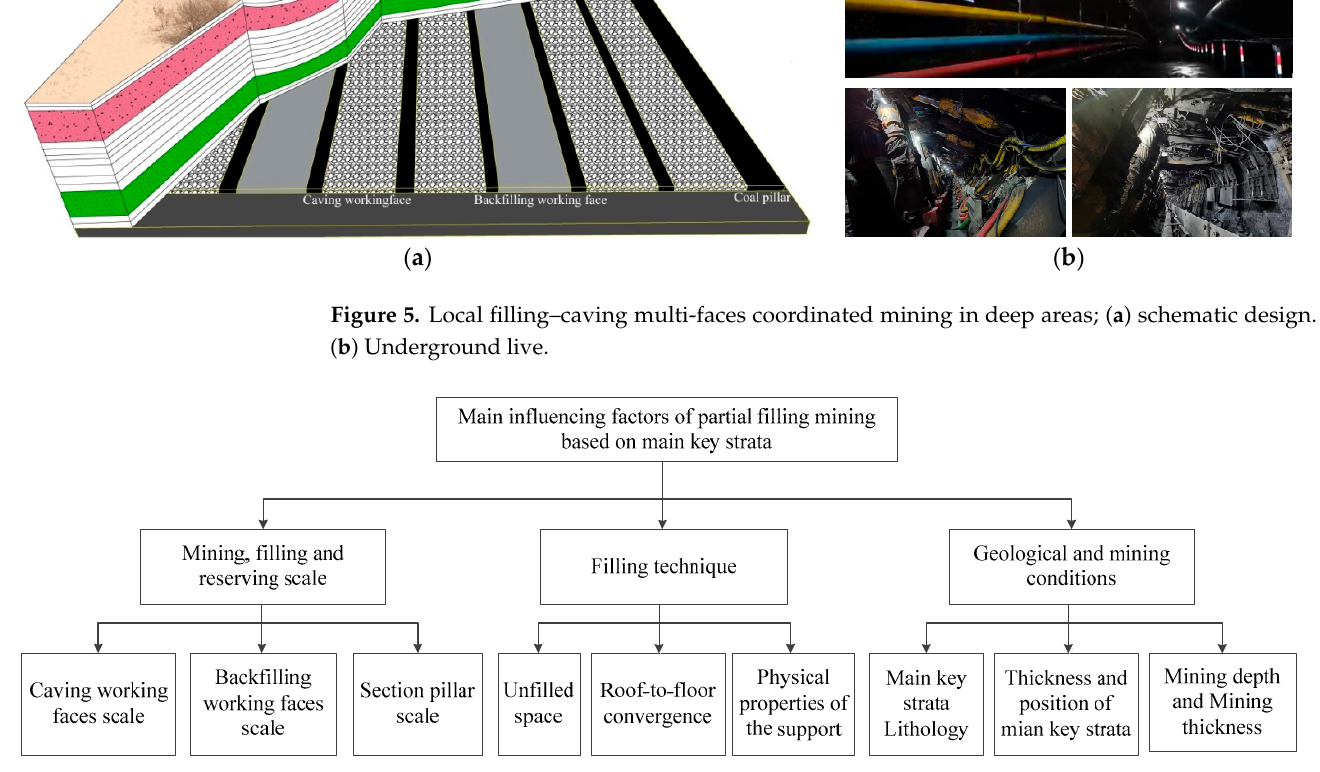
Figure 6. Surface subsidence caused by partial filling mining based on the main key stratum structure and the influencing factors of energy polling distribution control.